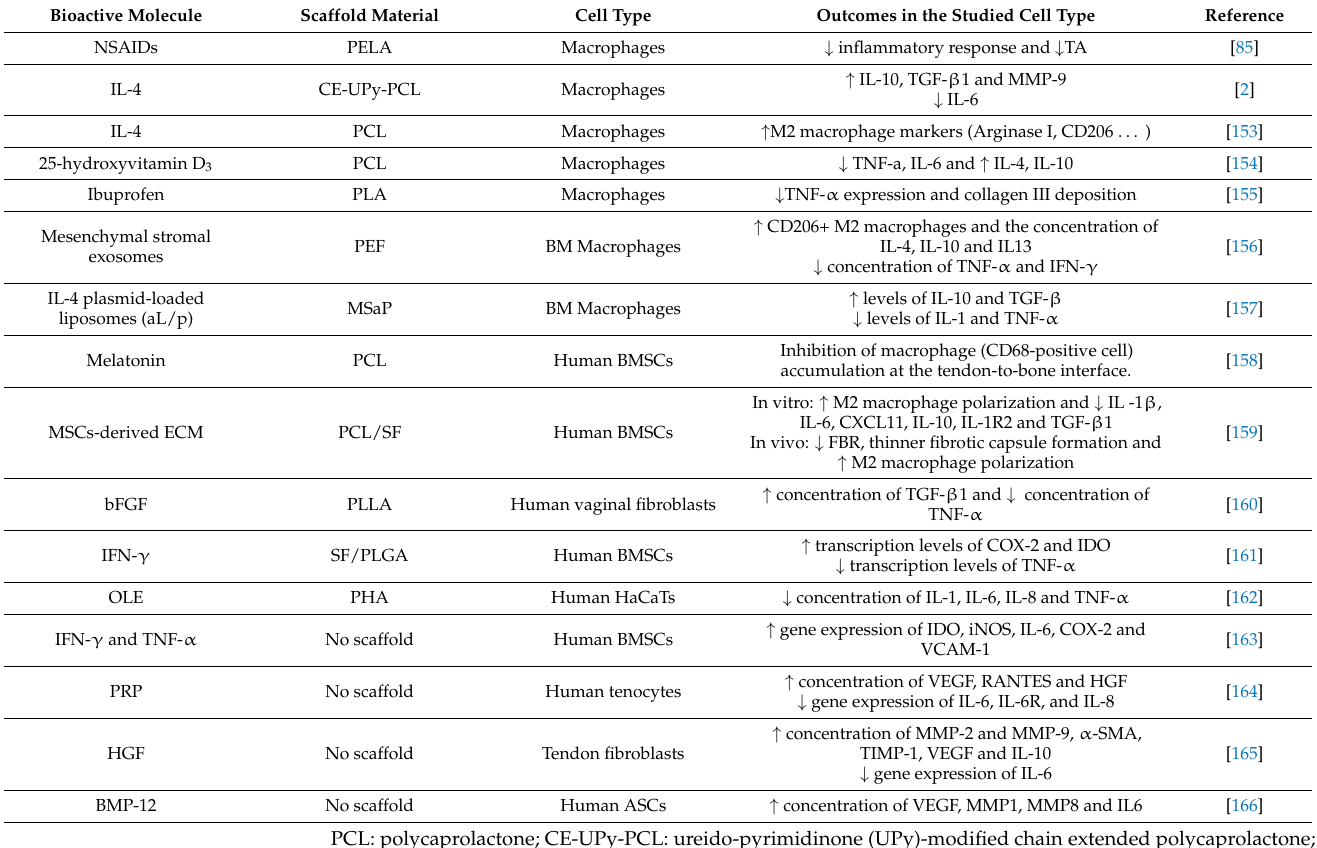
Table 3. Overview of the influence of bioactive molecules on the immunomodulatory properties of tenocytes, stem and immune